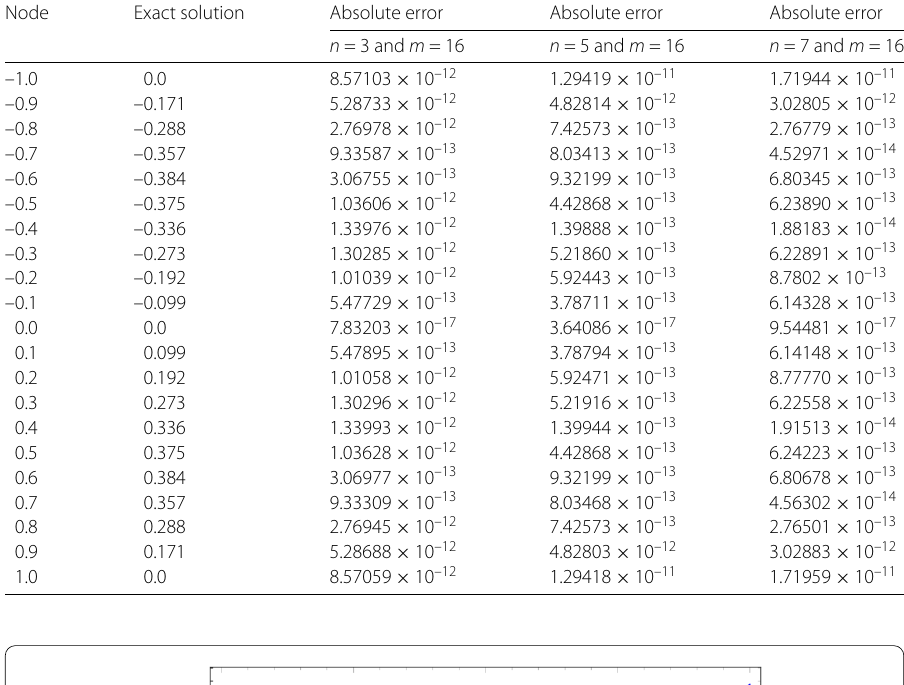
Table 1 Absolute error for Example 1